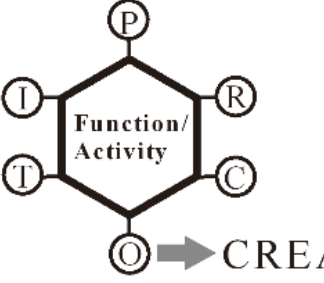
Figure 1. Hexagonal structure of FRAM.